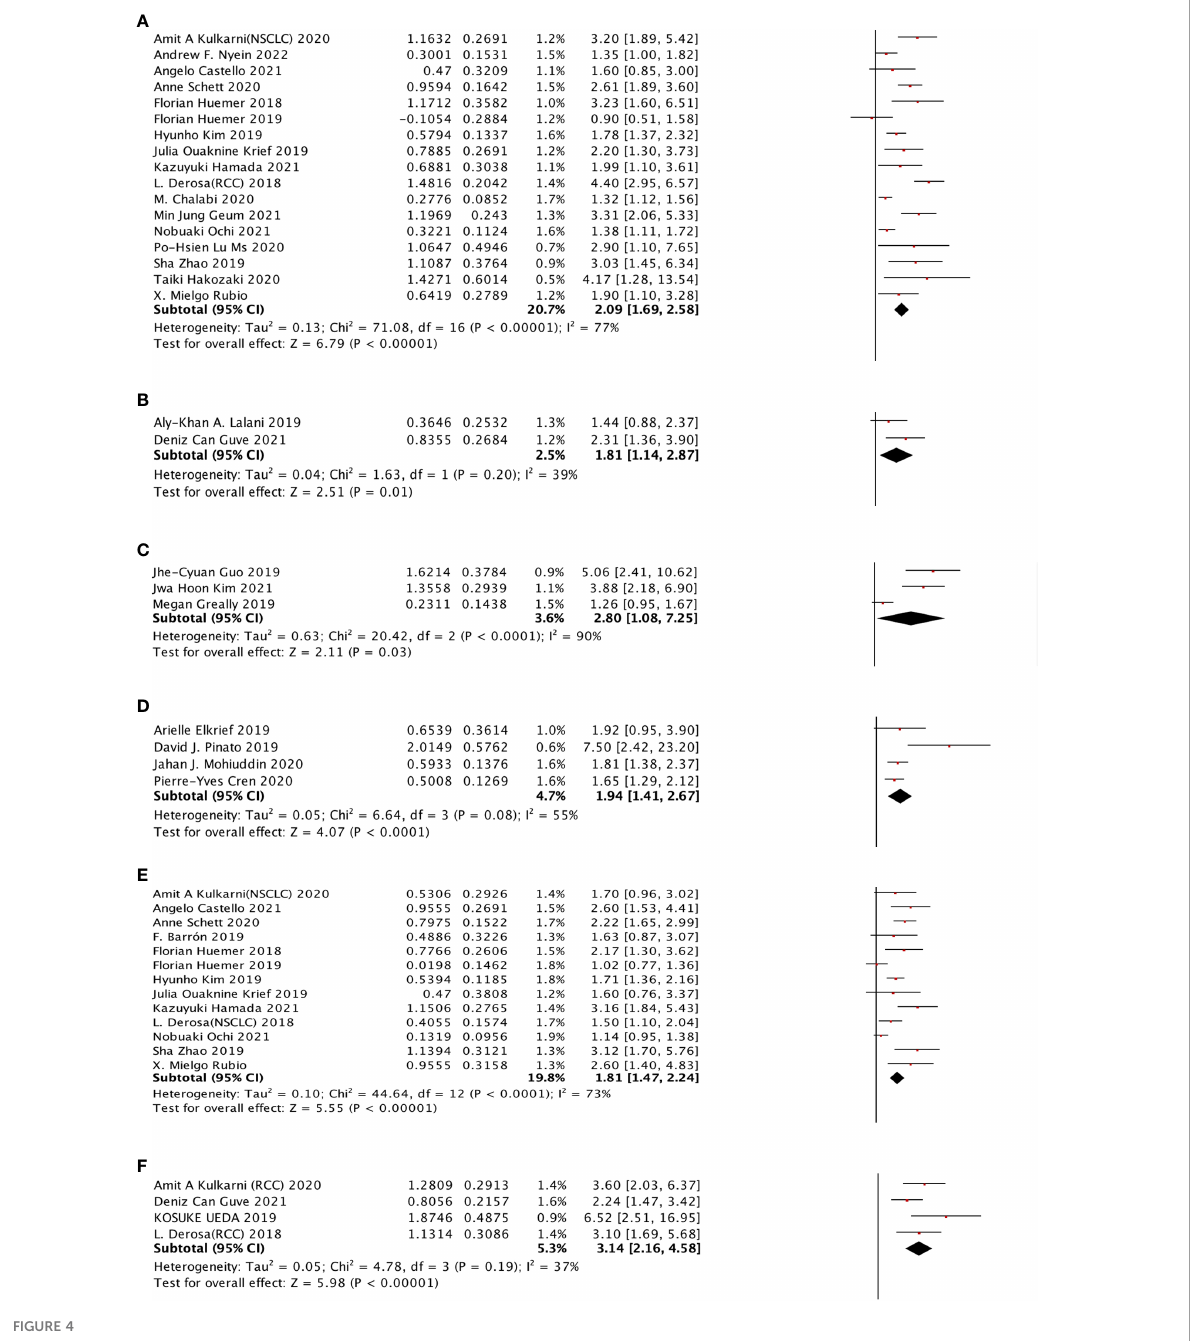
FIGURE 4 The subgroup analysis between ATB use and cancer prognosis (OS + PFS) of RCC and NSCLC cancer patients treated with ICIs. (A) The relationship between ATB use and OS of NSCLC patients treated with ICIs. (B) The relationship between ATB use and PFS of RCC patients treated with ICIs. (C) The relationship between ATB use and OS of esophagus cancer patients treated with ICIs. (D) The relationship between ATB use and OS of melanoma patients treated with ICIs. (E) The relationship between ATB use and PFS of NSCLC patients treated with ICIs. (F) The relationship between ATB use and PFS of RCC patients treated with